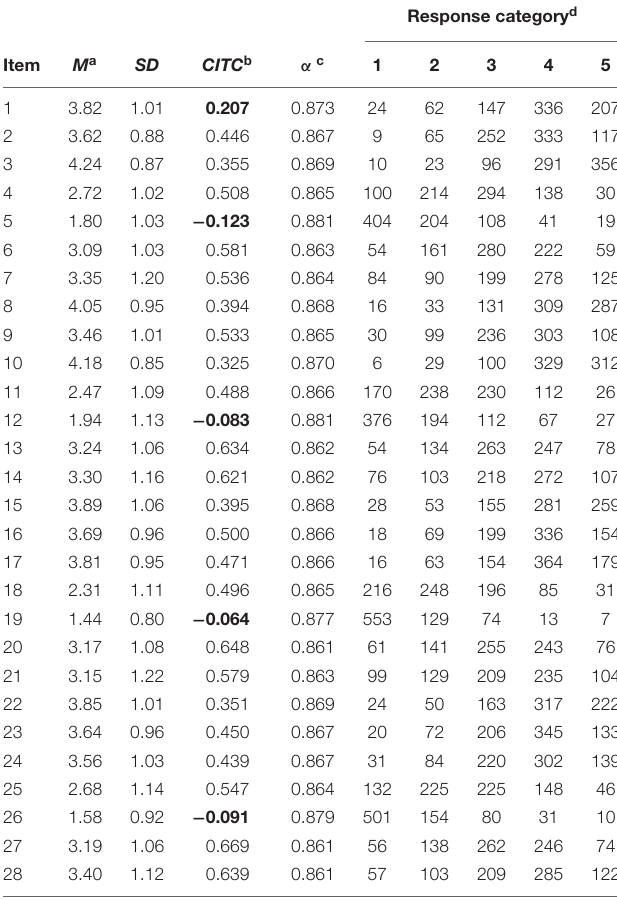
TABLE 1 | Classical item analysis of the AMS ( α = 0.87, CI 95 = 0.86,